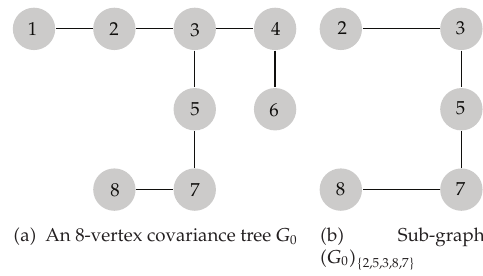
Figure 1: Covariance graph in Example